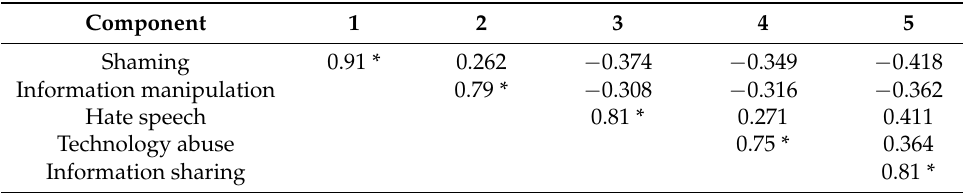
Table 3. Factor intercorrelations—experiencing cyber-violence subscale.